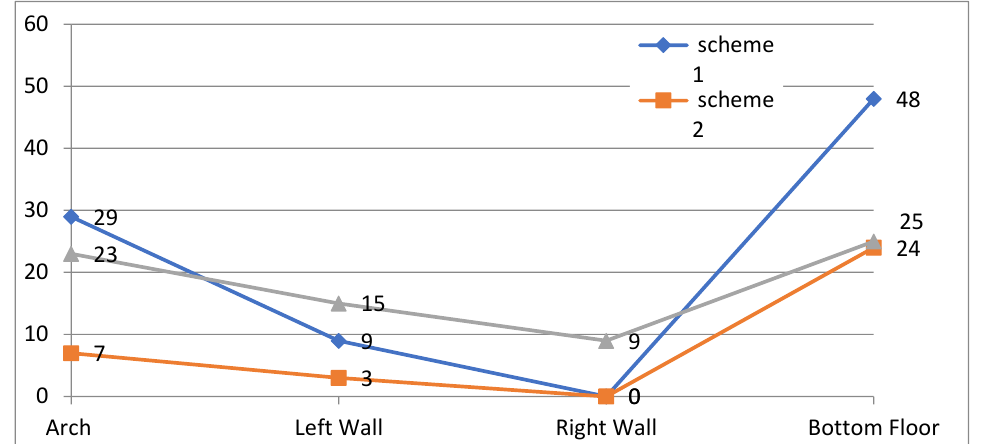
Figure 8. Crack depth (m) of SR after excavation of main powerhouse.